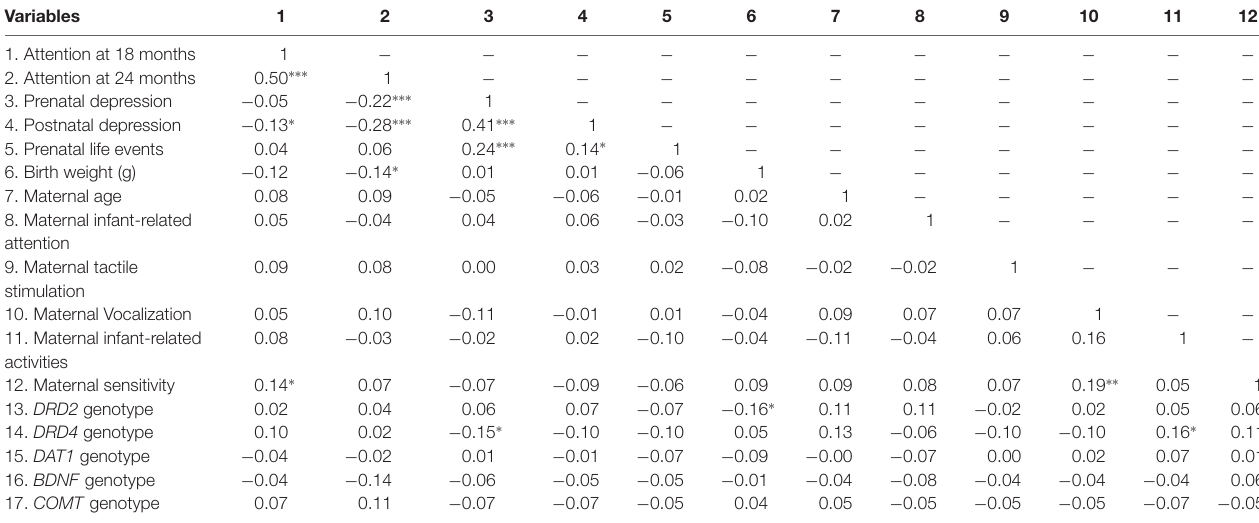
TABLE 2 | Kendall-Tau correlation matrix of all variables included in